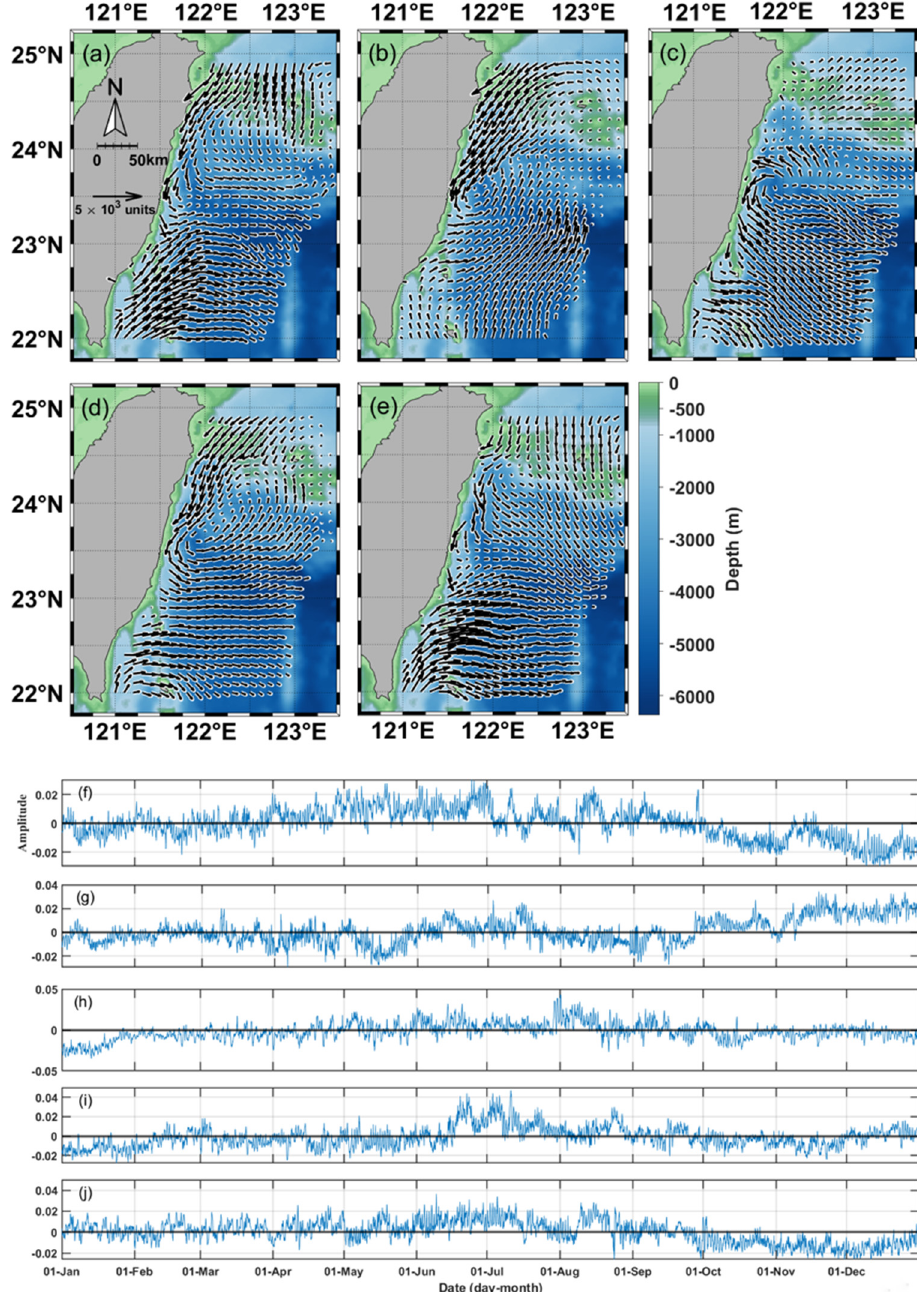
Figure 7. Same as Figure 6, but for EOF2. From the spatial patterns of EOF2 in 2016 and 2017 and EOF3 in 2015, 2018, and 2019, one can see a single eddy located at around 23 ◦ N, 122 ◦ E. Combined with the corresponding principal component, a cyclonic (an anticyclonic) eddy corresponds to a positive (negative) value. If a cyclonic (an anticyclonic) eddy approaches the Kuroshio off eastern Taiwan, it will decrease (increase) the Kuroshio northward velocity and transport [28]. Nevertheless, it is difficult to find obvious exchange regularity between the positive and negative values of the corresponding principal components. Previous studies have mentioned that eddies approaching the Kuroshio region east of Taiwan Island affected the Kuroshio at different periods, e.g., 30–70 days [29,30] and 100–200 days [4,30,31]. The above-mentioned results indicate that the various periods of the Kuroshio range from 30 to 200